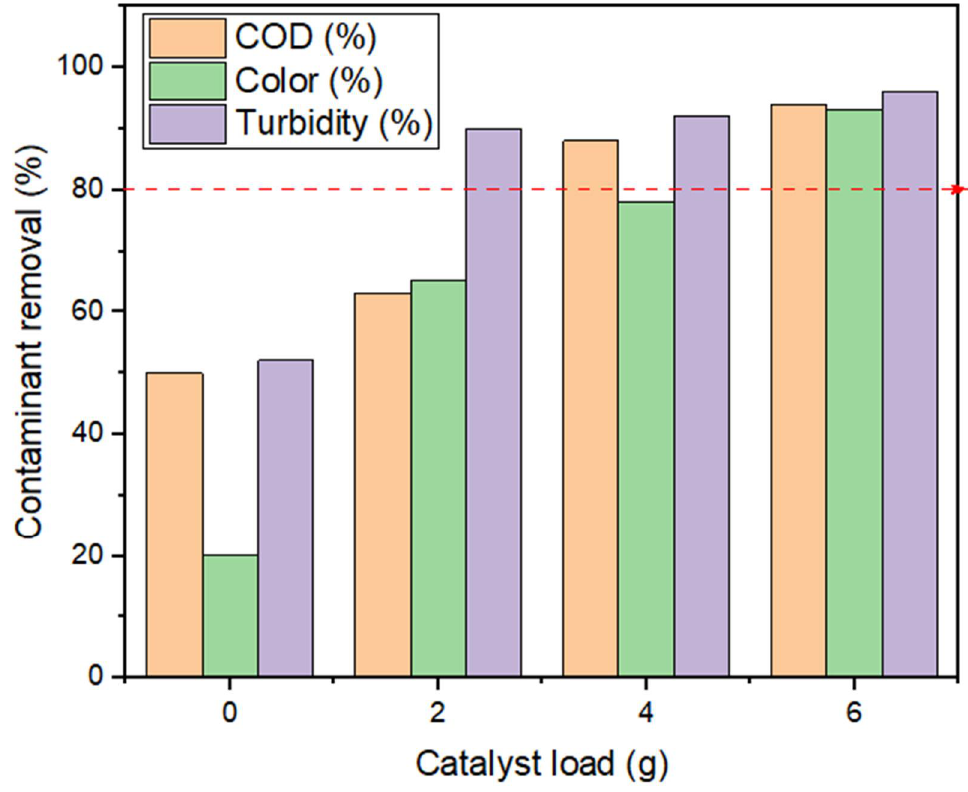
Figure 3. The effect of a weekly catalyst load of Fe-TiO 2 on biogas production using the biophoto- Figure 2. The effect of a weekly catalyst load of Fe-TiO 2 on contaminant removal by using the catalytic system for 30 days biophotocatalytic system.